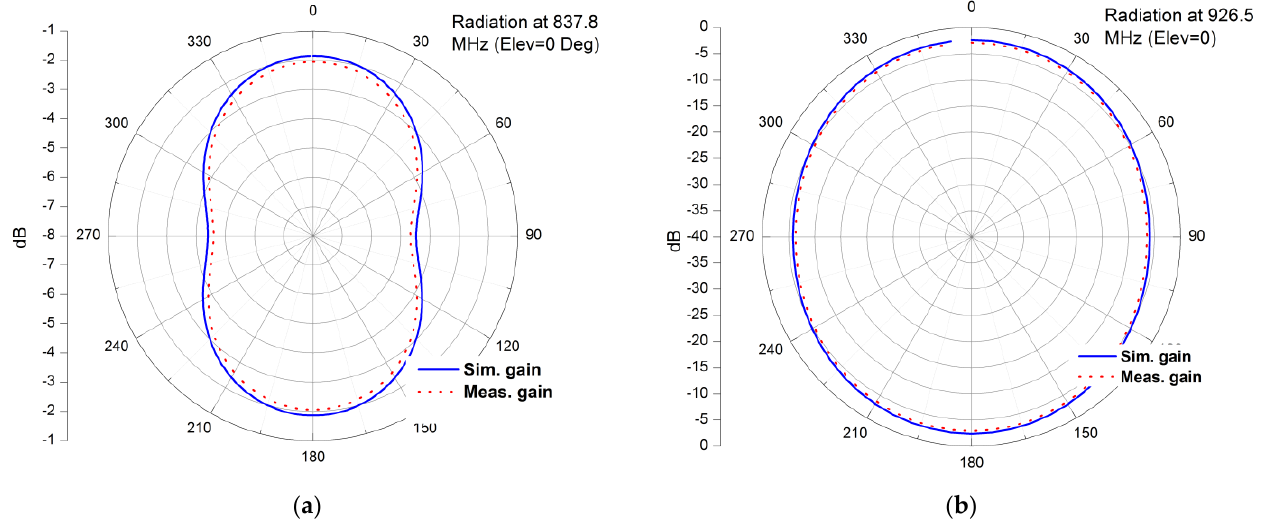
Figure 17. Reflection coefficient (S 11 ): simulations versus measurements.